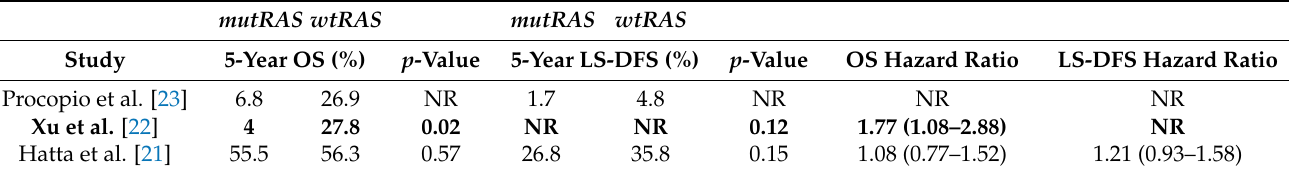
Table 4. Impact of RAS mutational status on survival after R1